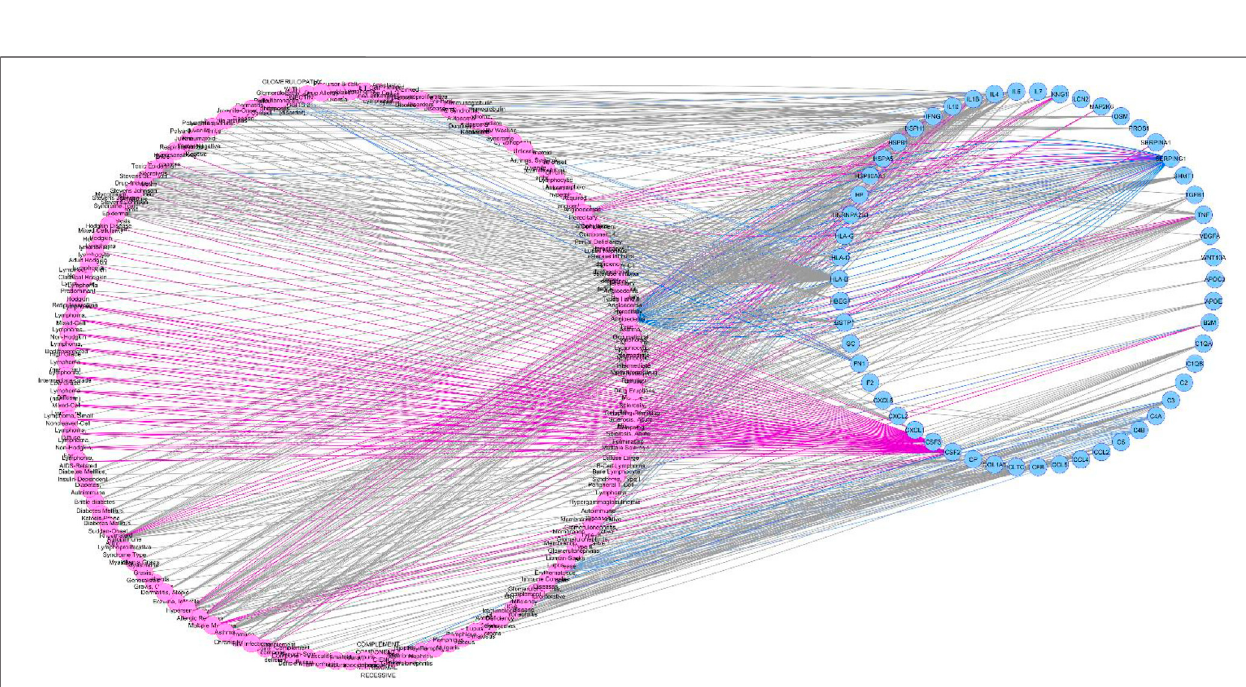
Frontiers in Genetics |